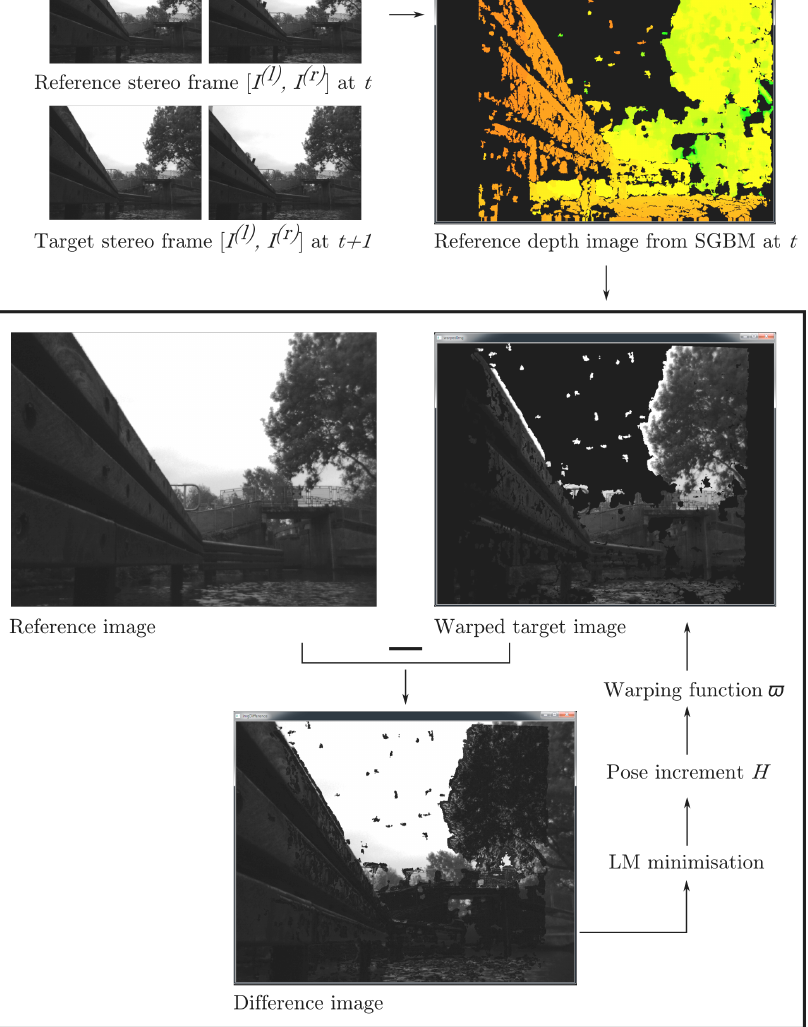
Figure 4. Illustration of the dense visual odometry algorithm for the final image pyramid level [27,28]; SGBM and LM stand for semi-global block matching and Levenberg–Marquardt,